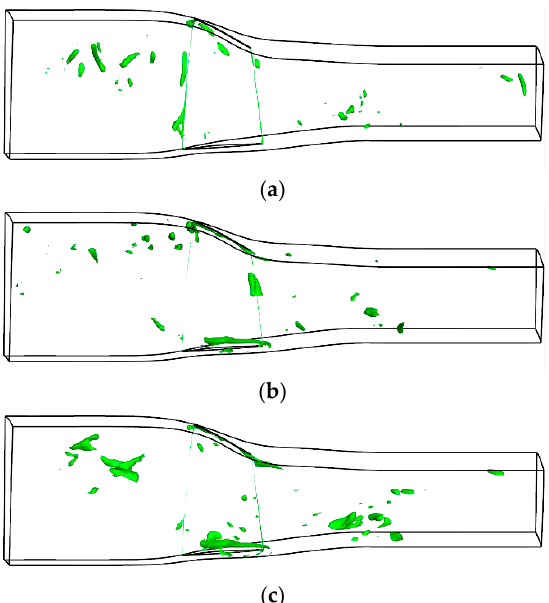
Figure 13. Iso − surface of the Liutex components at the NS condition. ( a ) Liutex components in the x − axis. ( b ) Liutex components in the y − axis. ( c ) Liutex components in the z − axis.